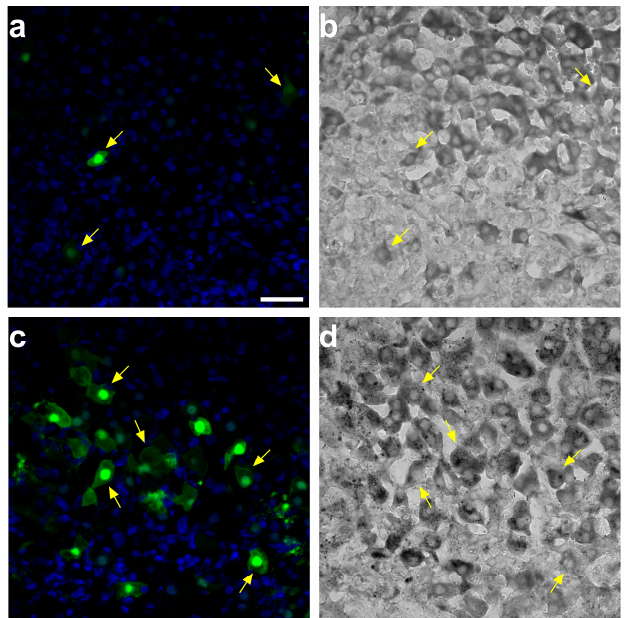
Figure 5. EGFP detection in fixed frozen adrenal tissue sections treated with TrueBlack. The native fluorescence of EGFP in the adrenal tissue treated with TrueBlack ( a ) and the corresponding trans- mitted image ( b ). EGFP staining with chicken anti-GFP Polyclonal antibody and goat anti-chicken IgY H&L (Alexa Fluor TM 488) after treatment with TrueBlack ( c ) and the corresponding transmitted image ( d ). Arrows represent cells stained with TrueBlack and exhibit green fluorescence. Images in ( a ) and ( b ) were obtained using different acquisition settings. Bar: 30 μ m. Abbreviations: TrueBlack, TrueBlack TM Lipofuscin Autofluorescence Quencher.